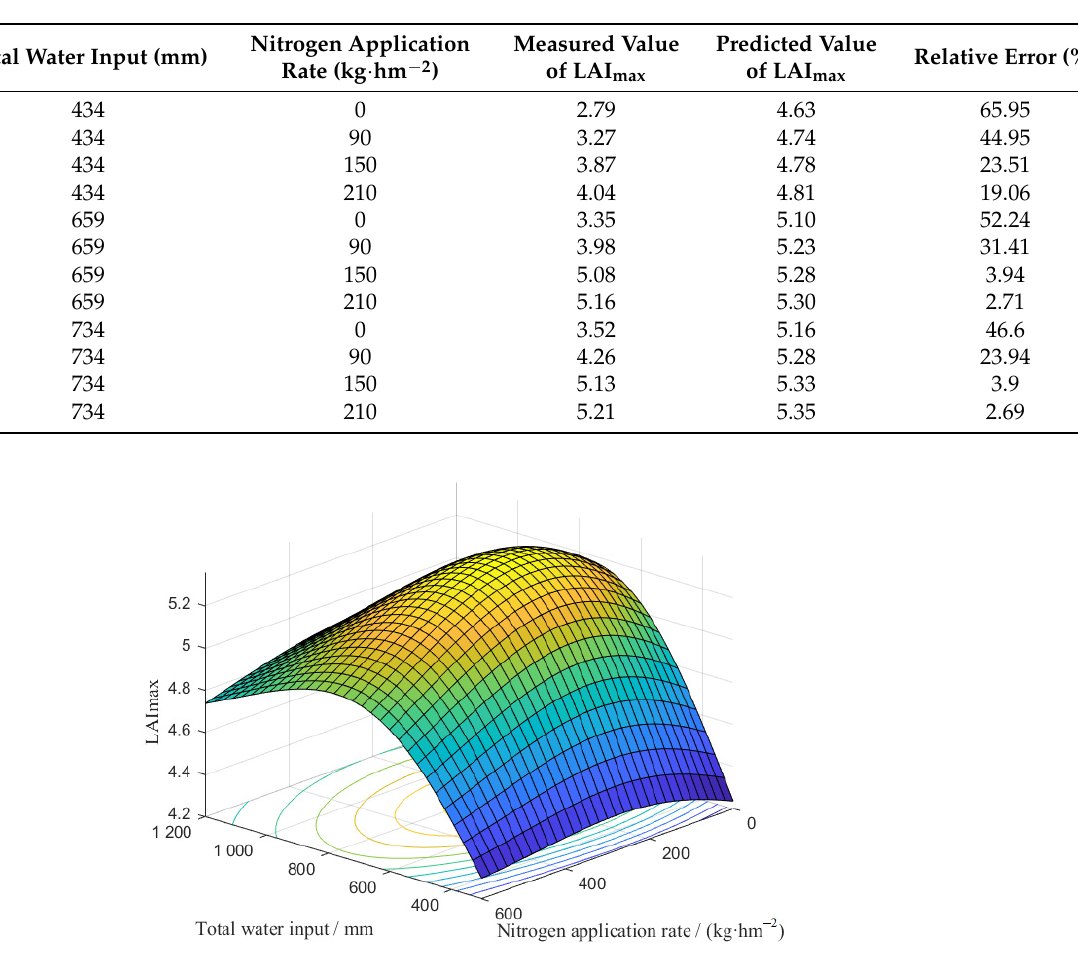
Figure 2. Regression model for maximum leaf area index for summer maize. Table 2. Relative leaf area index ( RLAI ) values for the six treatments at different points in time and mean RLAI values for all treatments in 2009.